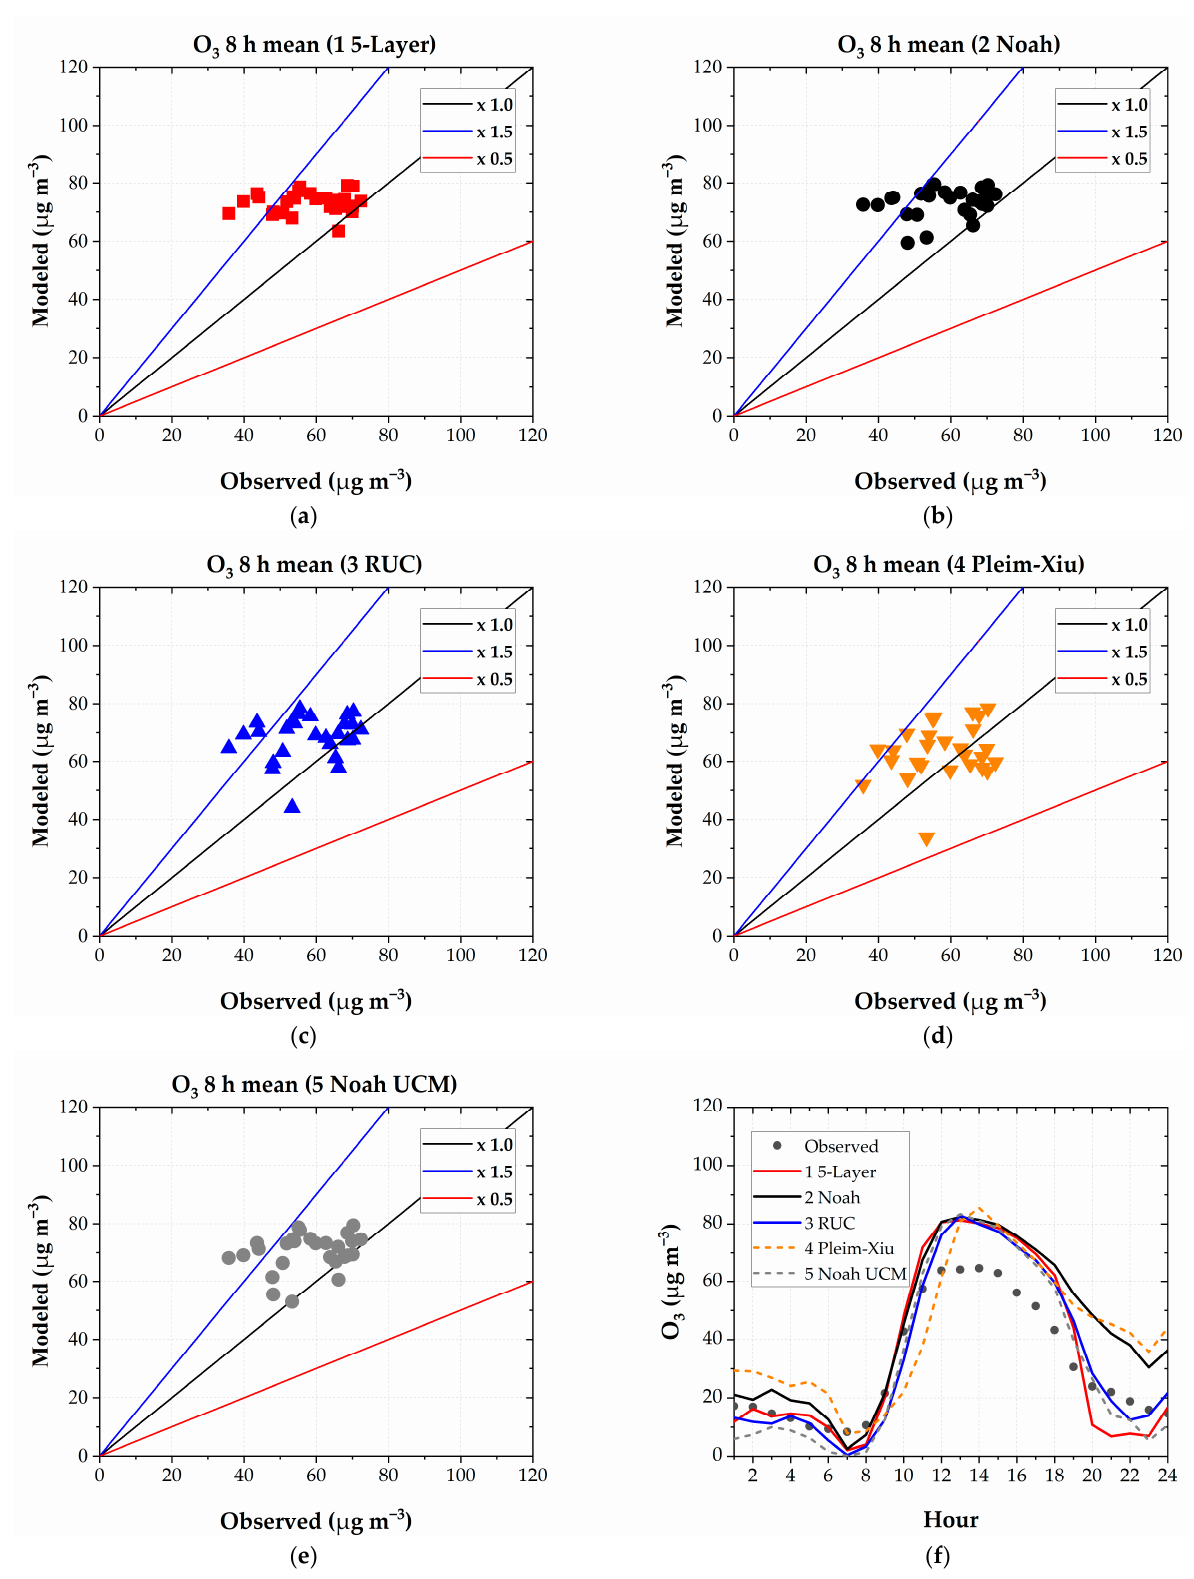
Figure 8. Observed versus modeled daily O 3 8 h maximum mean at the MUN station: ( a ) 1 5-Layer; ( b ) 2 Noah; ( c ) 3 RUC; ( d ) Pleim–Xiu; ( e ) 5 Noah UCM. ( f ) The mean daily profile of hourly O 3 concentrations.